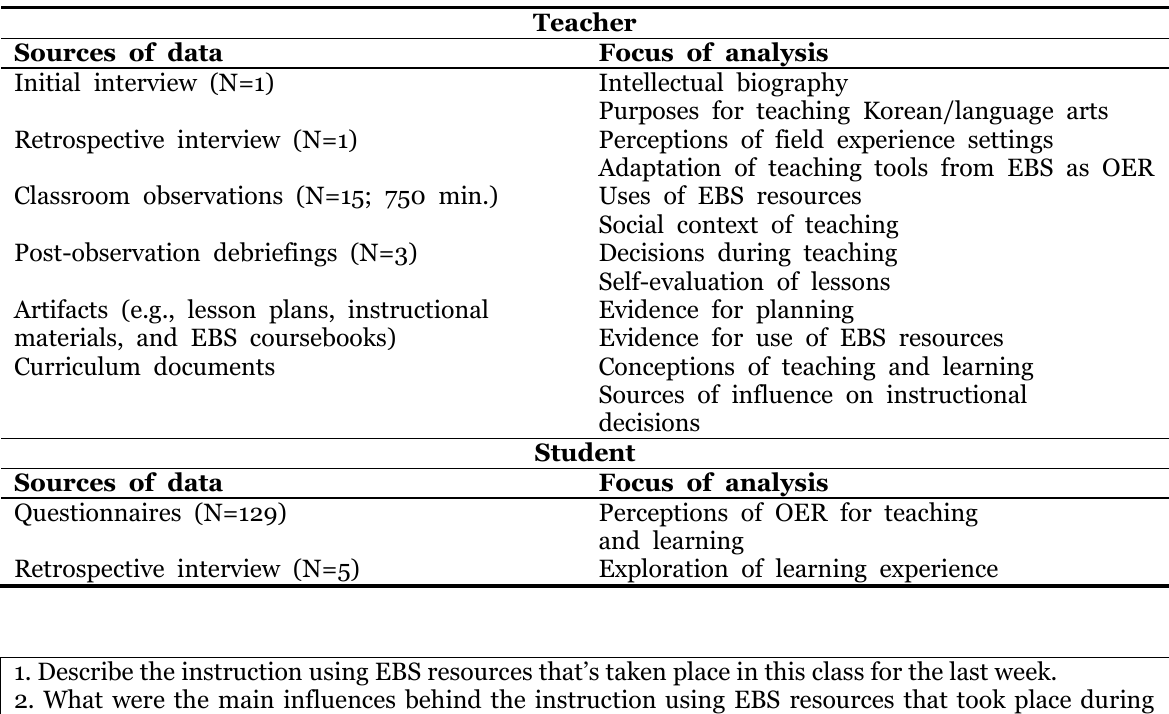
Table 2 Summary of Collected Data and